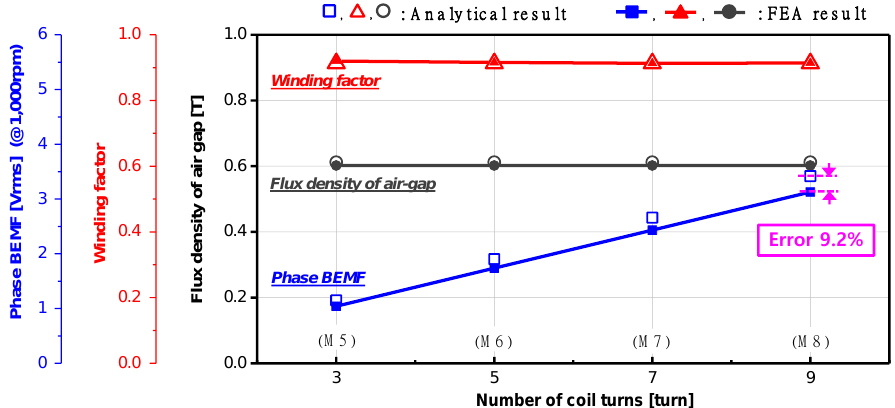
Figure 14. Back EMF trend according to the variation in the number of coil turns.